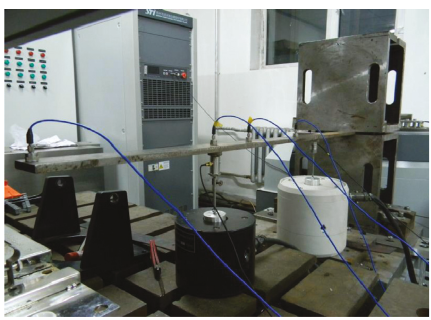
Figure 3: Photo of cantilever beam experiment setup. Table 1: Geometry and material parameters of cantilever beam at reference temperature (RT: 25 ° C). Length